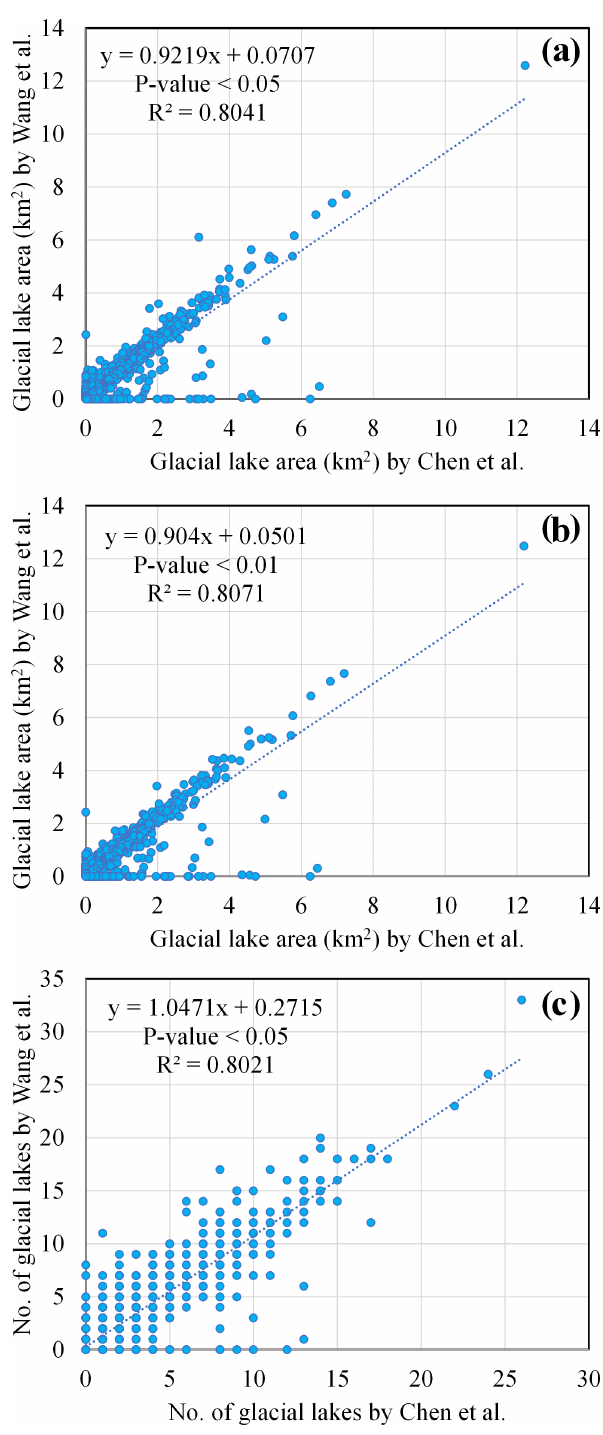
Figure A4. Comparison of the results of (a) total glacial-lake area, (b) areas of glacial lakes larger than 0.04km 2 , and (c) number of glacial lakes larger than 0.04km 2 summed over a 0.1 ◦ × 0.1 ◦ grid between the Hi-MAG database and the inventory of X. Wang et al. (2020).